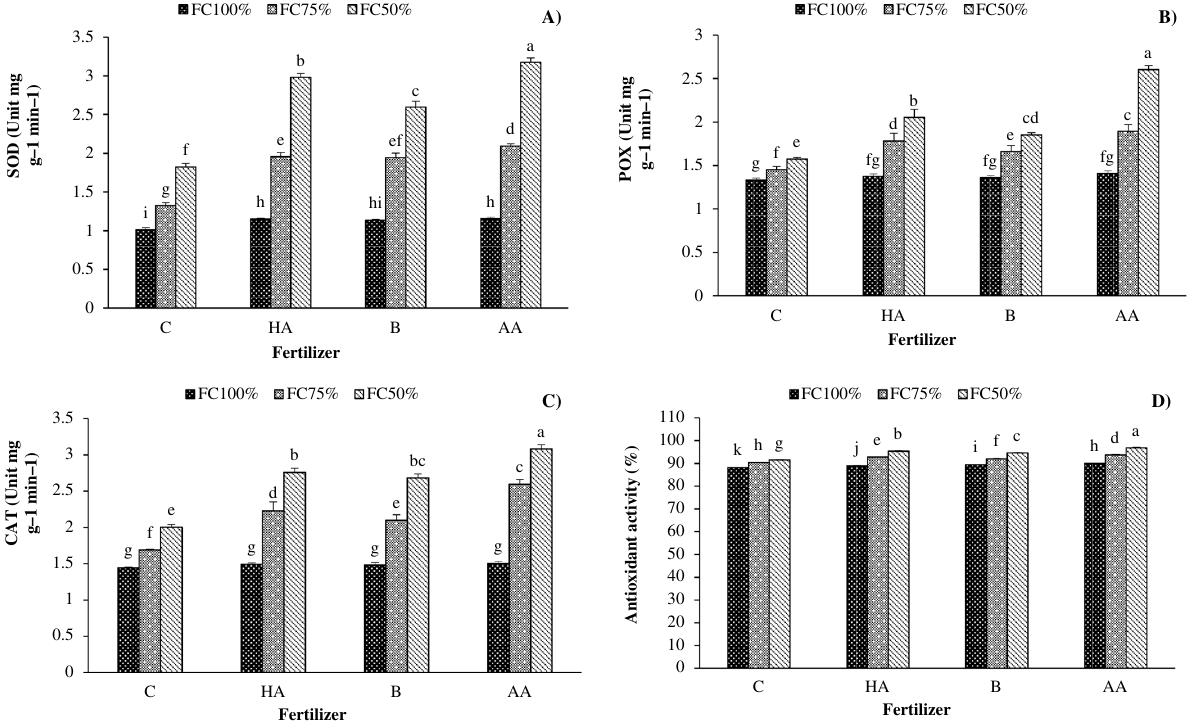
Figure 4. Interaction effects of irrigation regime and biofertilizer application on ( A ) superoxide dismutase activities, ( B ) peroxidase, ( C ) catalase, and ( D ) Antioxidant activity in savory. C control, HA humic acid, B bacterial, AA amino acid. Different lower-case letters above bars indicate significant differences at P <